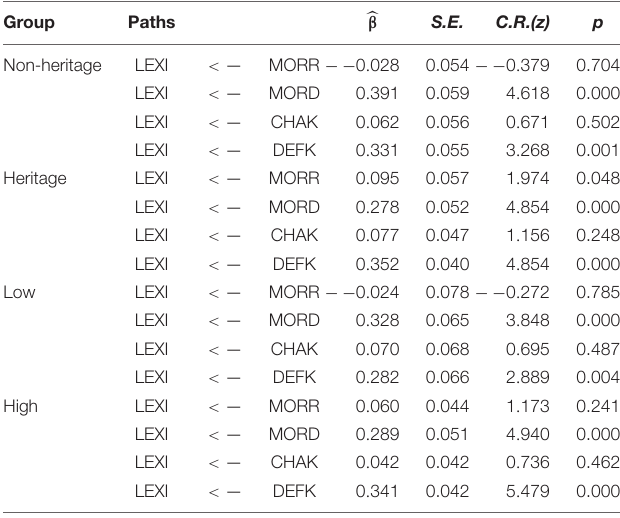
TABLE 2 | Standardized regression weights for measures of moderated path analysis.